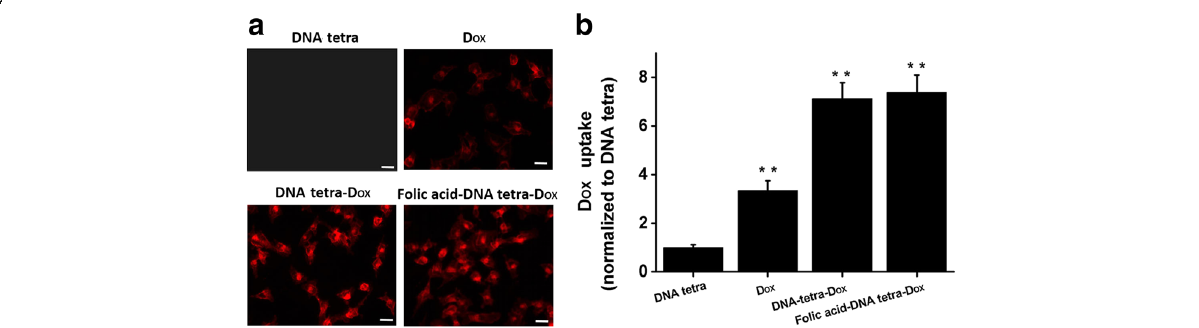
Fig. 3 The uptake efficiency of HT-29 cells after being incubated with different complexes for 24 h. a Confocal microscopy detection (red is fluorescence excitation light of Dox, scale bar = 10 μ m). b Intensity of cellular fluorescence. ** P < 0.05 when compared with the group of DNA